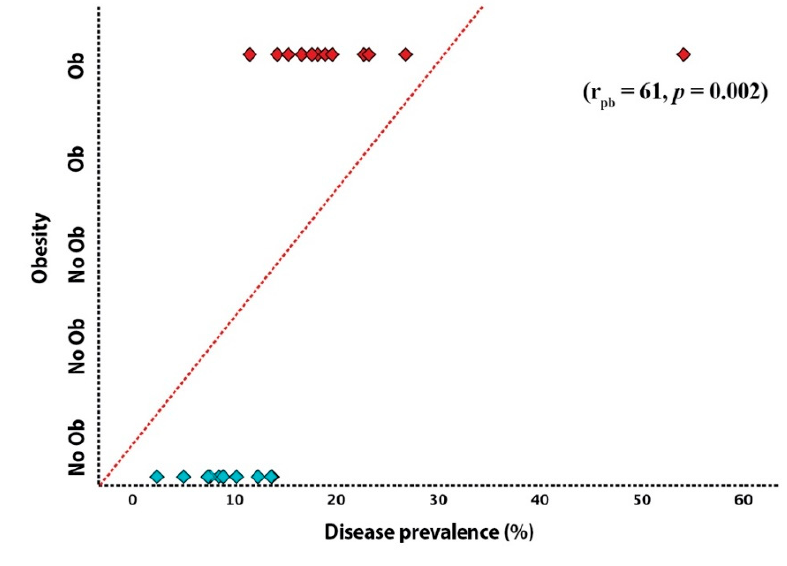
No Ob: no obese; Ob: obese Figure 3. Relationship between obesity and prevalence of COVID-19 among Clergy.